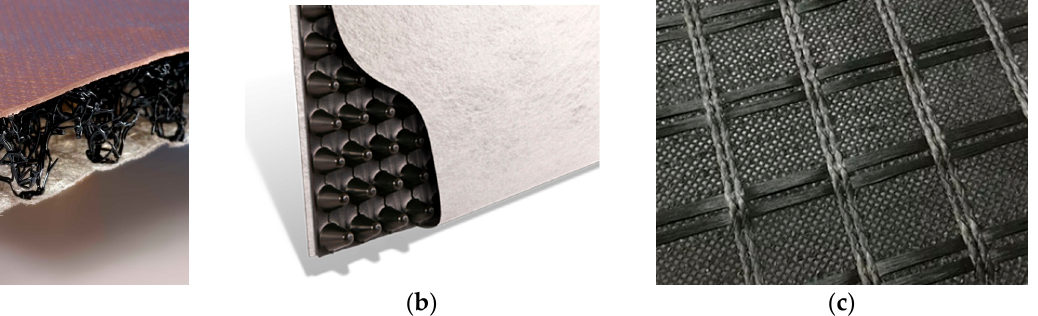
Figure 6. Examples of geocomposites: ( a ) drainage geocomposite; ( b ) drainage geocomposite; ( c ) reinforcement geocomposite.